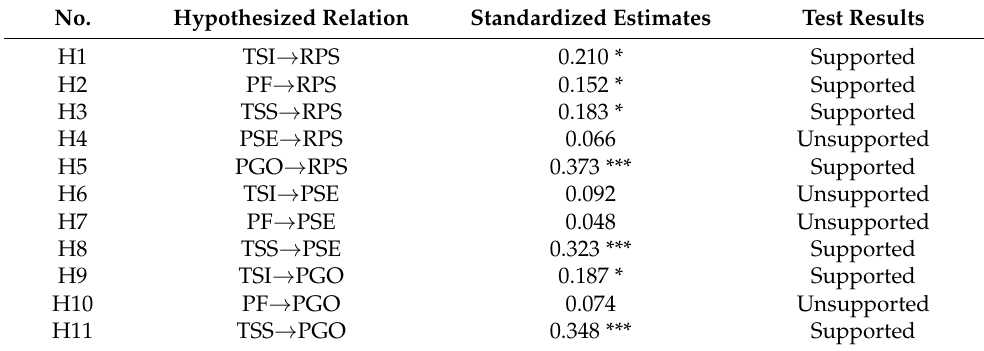
Table 5. Test of hypotheses in the structural model.